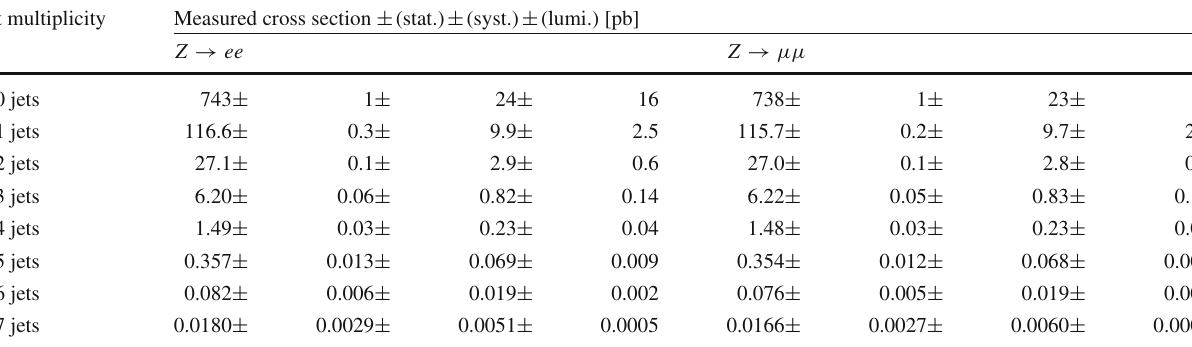
Table 3 Measured fiducial cross sections in the electron and muon channels for successive inclusive jet multiplicities. The total statistical and systematic uncertainties are given, along with the uncertainty in the luminosity Jet